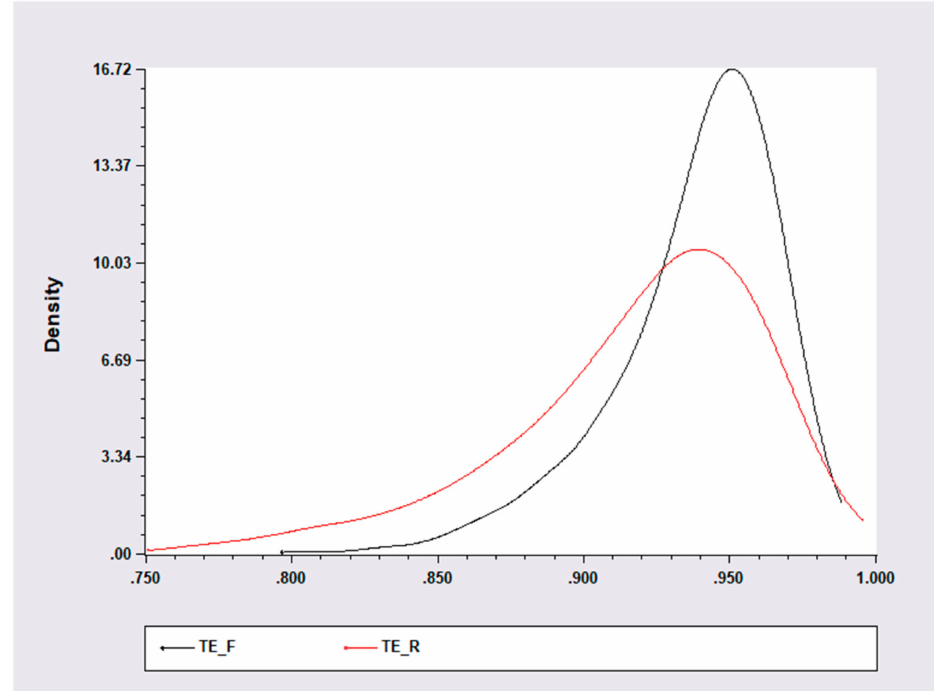
Figure 2. Kernel distribution of TE estimates for TFE_c (TE_F) and TRE_c (TE_R)